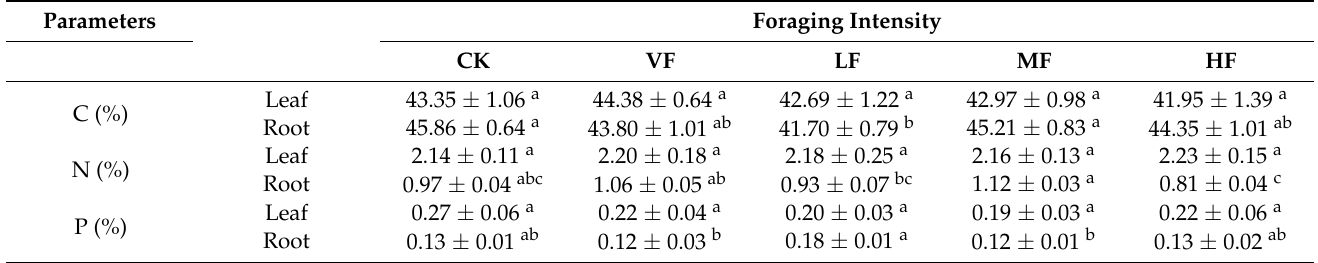
Table 2. C, N and P concentrations of leaf and root of C. thunbergii in different foraging